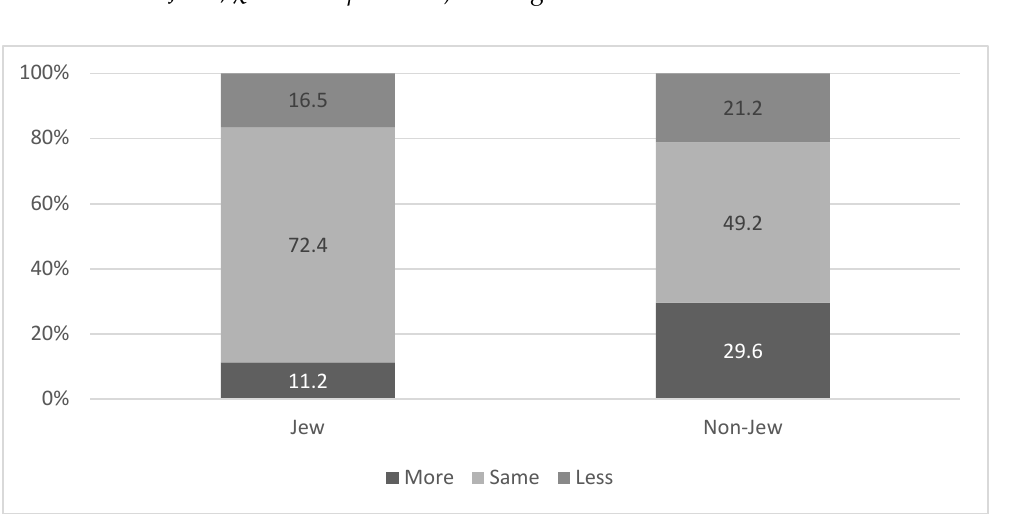
Figure 4. Change in social distancing following the vaccination campaign, according to ethnic affiliation. χ 2 = 50.06 p < 0.001.